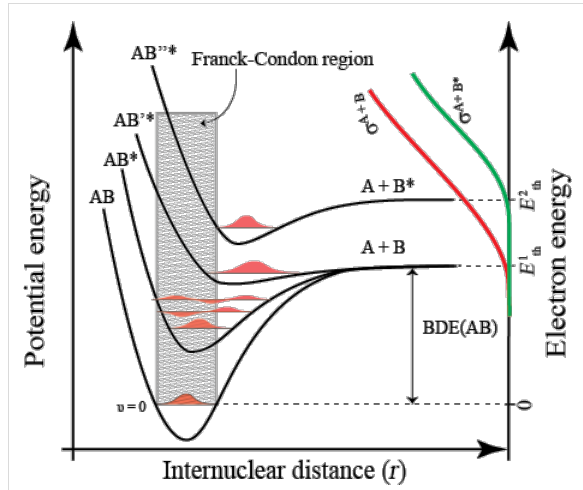
Figure 6: Simplified two-dimensional potential energy diagram for a quasi-diatomic dissociation through electronic excitation, i.e., neutral dissociation (ND). The excitation process is depicted as a vertical tran- sition from the neutral ground state to electronically excited states accessible within the Franck–Condon region (shaded area). Here, the two lower-lying excited states AB * and AB ′ * are shown as bound states and dissociation can only proceed through transitions to vibrationally excited states that are energetically above the respective dissociation limit. In this representation, both AB * and AB ′ * dissociate to form A and B in their respective ground states. The highest-lying excited state (AB ″ * ), on the other hand, is shown to be purely repulsive and to disso- ciate directly to form A and B * . On the right-hand y -axis, the energy dependence of the relative cross section for the formation of A and B and A and B* ( σ A+B and σ A+B* ) are shown as red and green lines and the total cross section for ND ( σ Tot ) is shown with a solid line as the sum of the two partial cross sections. The threshold energy ( E Th ) for the respective processes is indicated on the right-hand y -axis. Simi- larly to DI and DEA, the situation in ND is more complex in the case of a polyatomic molecule, and intramolecular energy redistribution, multiple fragmentations, and rearrangement reactions may play an important